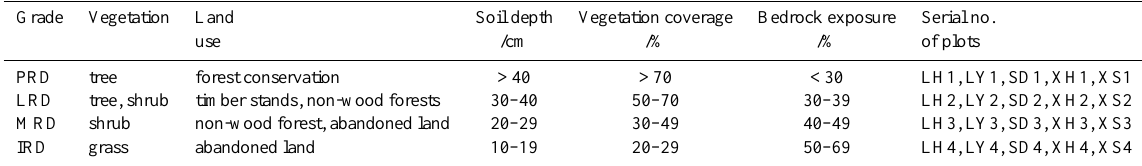
Table 1. Classification of rocky desertification and basic information of plots. Grade